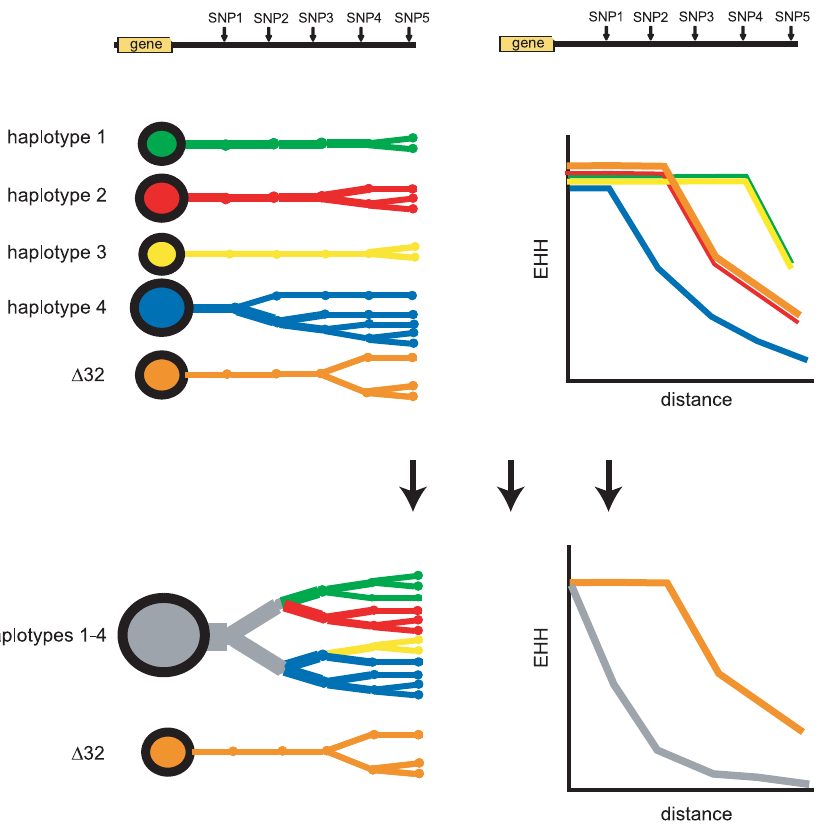
Figure 2. Model of Haplotype-Based Selection Approach The image compares this approach, where the variants at the gene being studied are fully elaborated, to a model where the variants are not fully elaborated. At the top, multiple SNPs are genotyped to fully define the variants that exist in the gene. The resultant observed haplotype structure is shown in both bifurcation diagram and EHH plot formats (see Materials and Methods). At the bottom, only one SNP is genotyped, collapsing all other variants into a seemingly diverse super-haplotype and creating an impression of extension for the remaining haplotype. DOI: